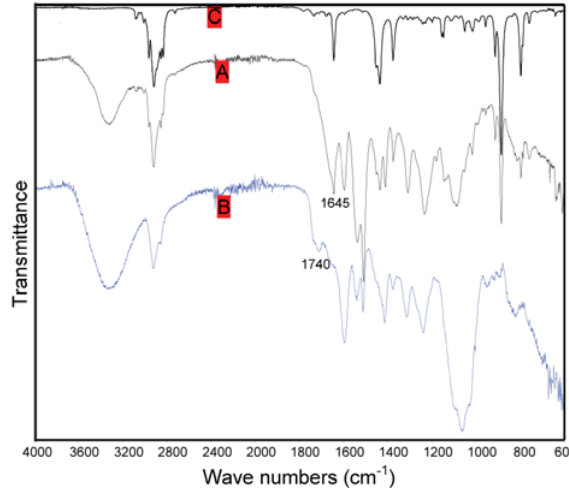
Figure 1. FTIR spectra of (A) the polyurea microcapsules, (B) the poly(urea-urethane) microcapsules, and (C) the core material (orange